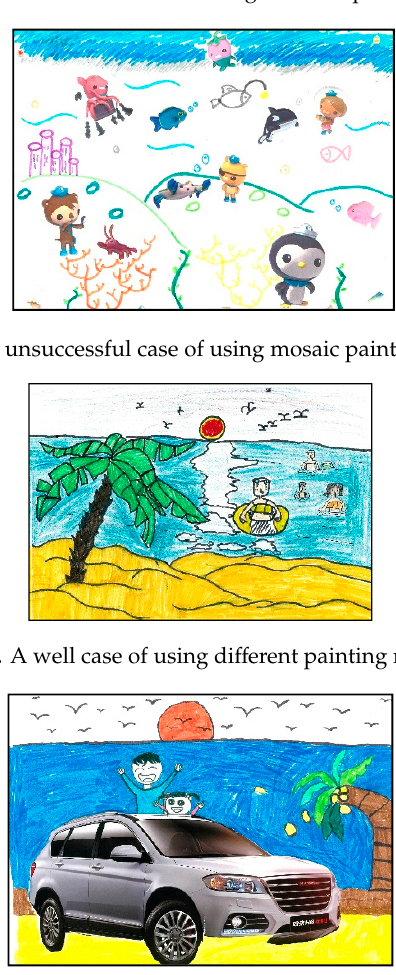
Figure 5. A successful case of using mosaic painting materials.